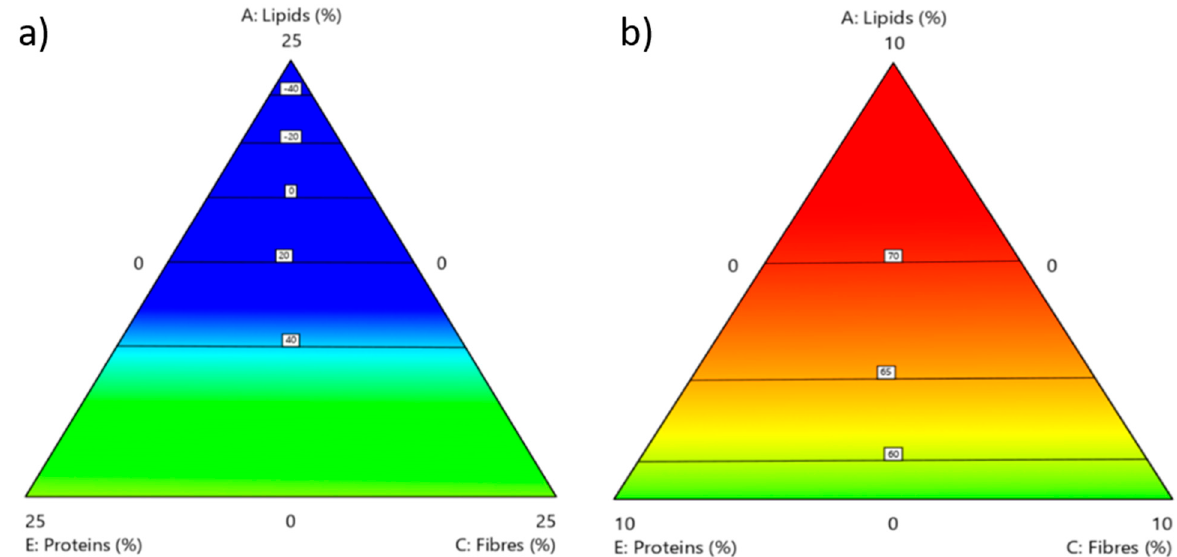
Figure 6. Graphical model variation of the amount of lysine in the proteins of BSF prepupae in relation to the composition of the rearing substrate in terms of lipids, protein and fibre, considering two scenarios: ( a ) carbohydrates = 75 wt%; ( b ) carbohydrates = 90 wt%. The region representing the highest value of the response is shown in red colour, whereas the lowest values are in blue. For each response, the most significant factor has been considered for the graphical model, expecting higher variation in the response behaviour. Table 3. Highest, lowest and average essential amino acid content of BSF prepupae, compared with the FAO protein reference for human adults